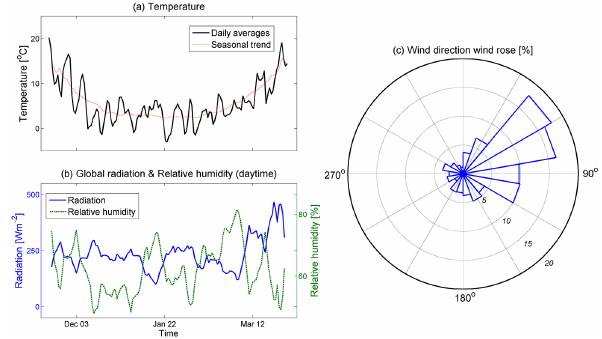
Fig. 2. Meteorological conditions during the measurement period 18 November–31 March. (a) Temperature with daily averages and seasonal trend. (b) Global radiation and relative humidity. (c) Wind direction wind